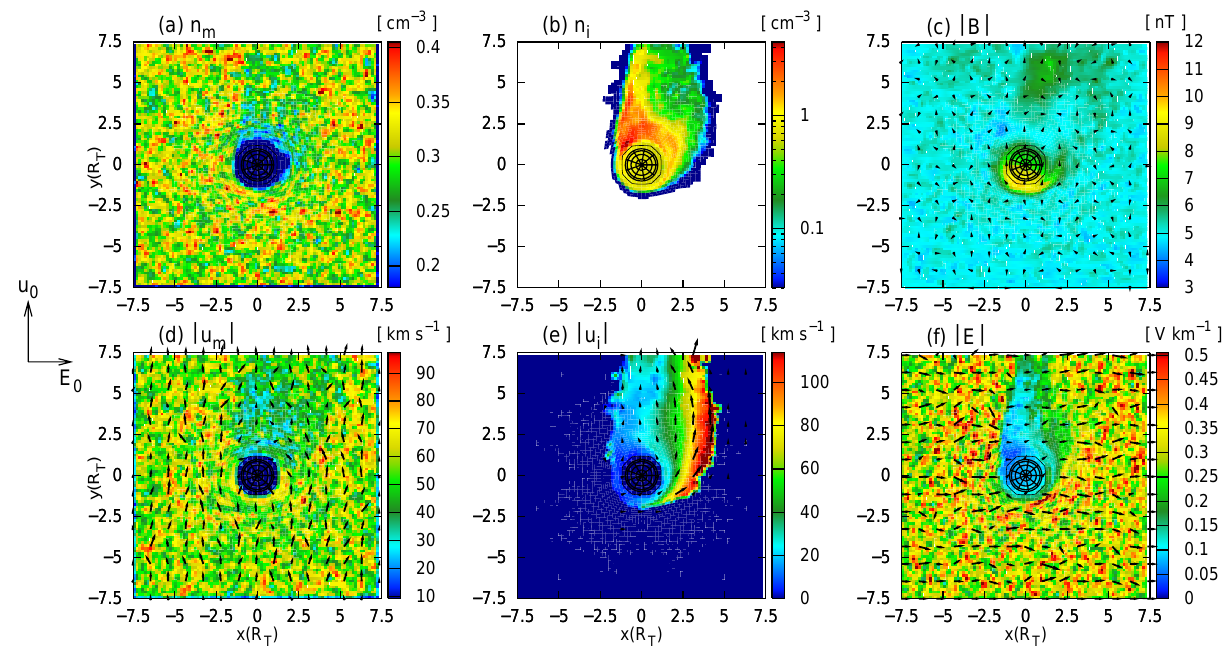
Fig. 18. Titan’s plasma environment at 00:00 Saturnian local time. The figure displays a cut through the equatorial plane of Titan which is perpendicular to the undisturbed magnetic field. The figure displays (a) the magnetospheric ion density, (b) the ionospheric nitrogen density, (c) the magnetic field strength, (d) the magnetospheric ion velocity, (e) the ionospheric ion velocity and (f) the electric field. As in the 06:00 LT and the 18:00 LT scenarios, the ionospheric tail exhibits a strong preference to expand into the E + hemisphere. However, since the value of the upstream plasma velocity is about 60% smaller than in the other simulation runs, the convective electric field and hence the Lorentz force that drags the ionospheric ions into the E + hemisphere are significantly weaker, yielding a tail diameter of only 5 R T in E + direction. In contrast to this, when the upstream flow is super-Alfv´enic, particles of ionospheric origin can be found in a distance of more than 7 R T perpendicular to the flow direction. Because the ionospheric ion velocity in the tail is comparable to the ambient plasma velocity, only an insignificant decrease of (convective) electric field strength occurs downstream of the